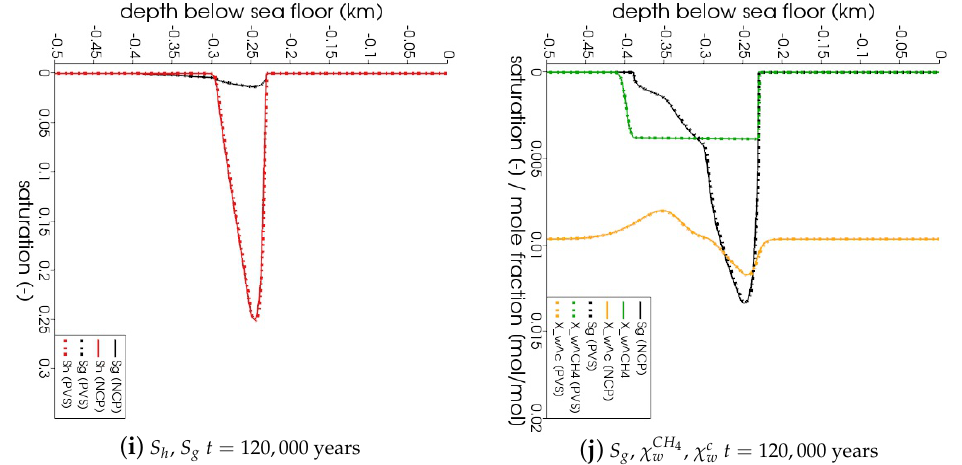
Figure 6. Numerical results for Example 1 (Section 4.1). Figure shows the process of hydrate dissociation → gas migration → hydrate reformation as a result of rising GHSZ between 60,000 years ≤ t ≤ 120,000 years. The new gas hydrate layer grows using the methane gas supplied by the dissociating gas hydrate layer